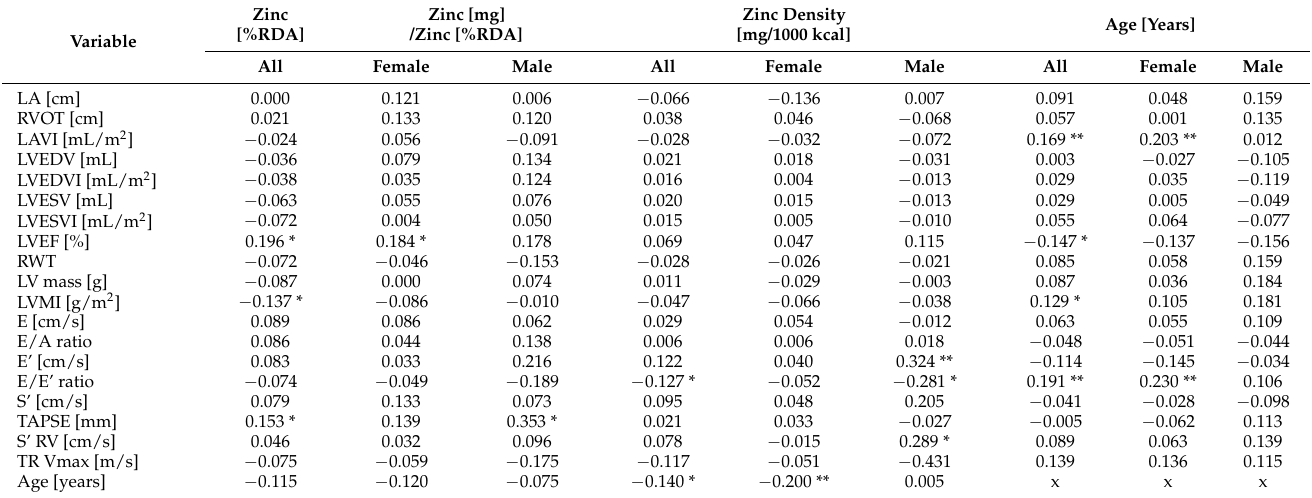
Table 3. Spearman’s correlations between echocardiographic parameters, zinc intake and